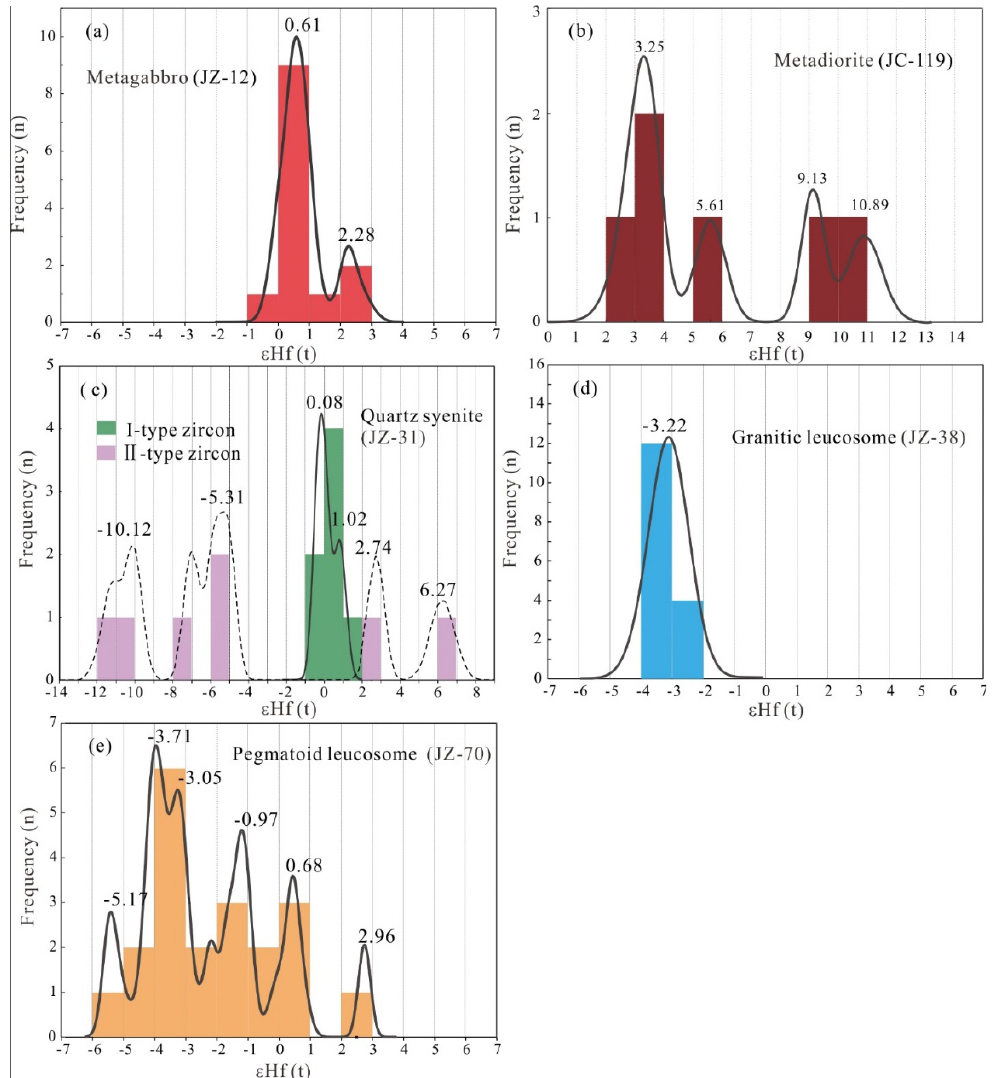
Figure 9. Probability plots of zircon εHf(t) values. ( a ) Metagabbro sample JZ-12; ( b ) metadiorite sample JC-119; ( c ) quartz syenite sample JZ-31; ( d ) granitic leucosome sample JZ-38; ( e ) pegmatoid leucosome sample JZ-70.